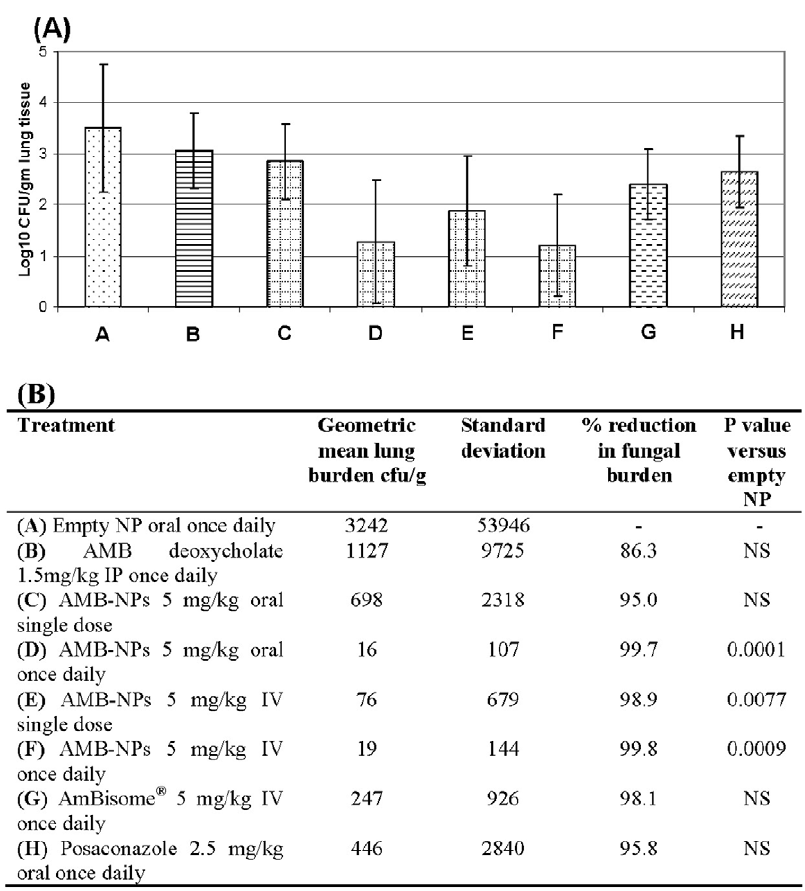
Figure 5. Lung burden of mice with invasive pulmonary aspergillosis treated with AMB-NPs, AMB deoxycholate, AmBisome and Posaconazole 101 hours post infection (Panel A). Geometric mean tissue burdens (and standard deviations) of mice with invasive pulmonary aspergillosis treated with AMB-NPs, AMB deoxycholate, AmBisome and Posaconazole 101 hours post infection ( Panel B ). The p values are from a Kruskal Wallis test (Conover-Inman).